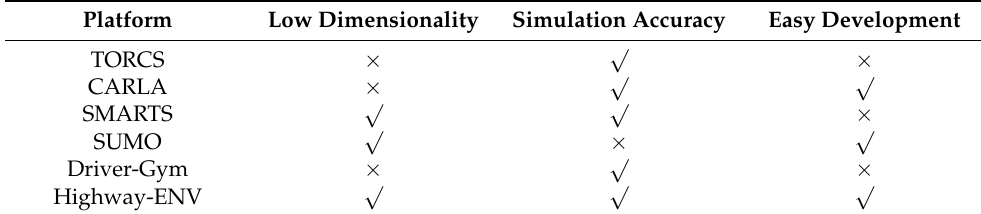
Table 1. Comparison of reinforcement learning simulation